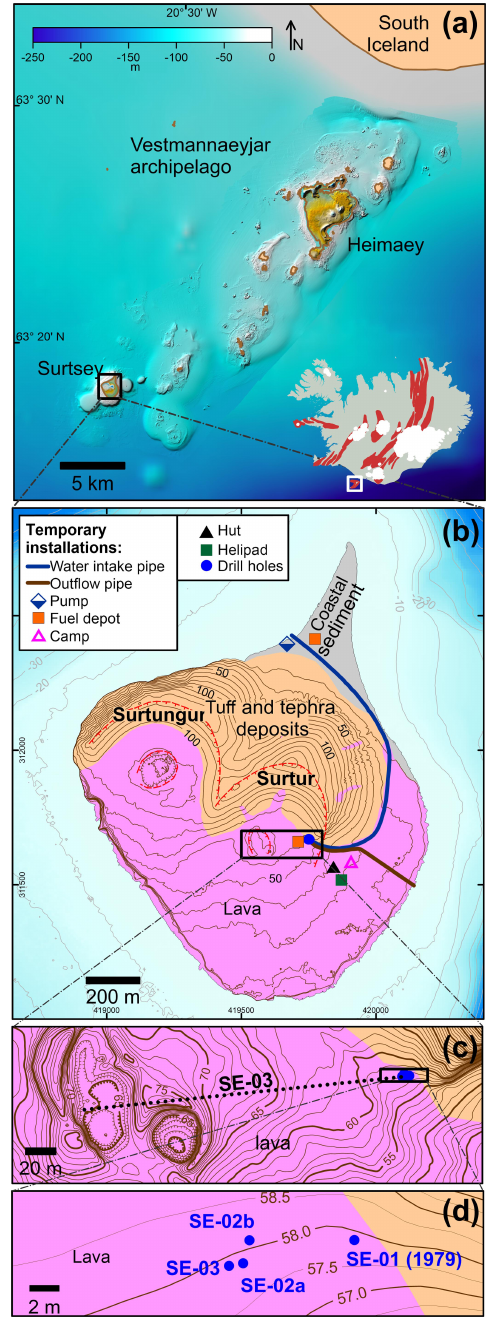
Figure 1. Maps showing drilling at Surtsey volcano, Iceland. (a) The Vestmannaeyjar volcanic archipelago at the southern off- shore extension of the eastern Iceland rift zone (bathymetry: Ice- landic Coast Guard, Hydrographic Department). The red elongated patches on the Iceland map show individual volcanic systems. (b) A simplified geological map of Surtsey (following Jakobsson, 2000) and temporary installations of the 2017 SUSTAIN drilling opera- tion. The red dashed tick lines indicate crater rims. (c) Horizontal projection of the SE-03 (5059-1-D) cored borehole. (d) Wellhead locations: SE-01 (1979) and SE-02b, SE-02b, and SE-03 (or 5059- 1-B, 5059-1-C, and 5059-1-D)